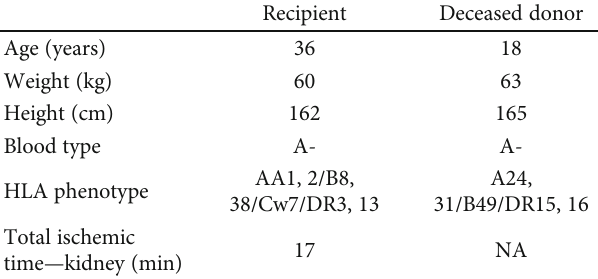
Table 1: Recipient and deceased donor